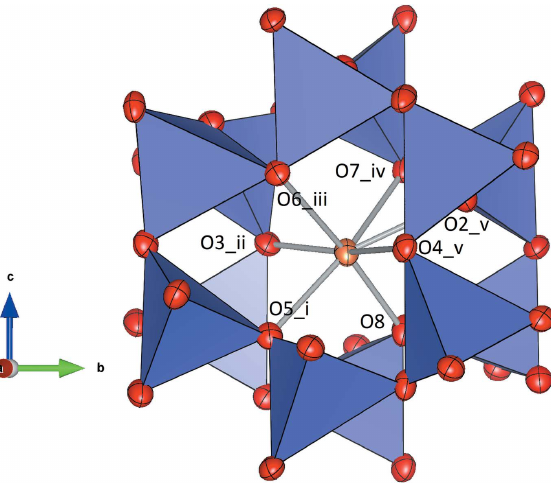
Figure 3 Representation of the coordination polyhedron around Sr2. Ellipsoids (cid:4) x , 1 (cid:4) z ; (ii) are drawn at the 70% level. [Symmetry codes: (i) 3 + y , 1 2 2 2 1 (cid:4) x , 1 (cid:4) z ; (iii) 1 (cid:4) y , (cid:4) 1 + y , 1 + x , 3 + z ; (iv) 1 (cid:4) x , 1 (cid:4) y , 1 (cid:4) z ; (v) x , 1 + y , 2 2 2 2 2 2 z